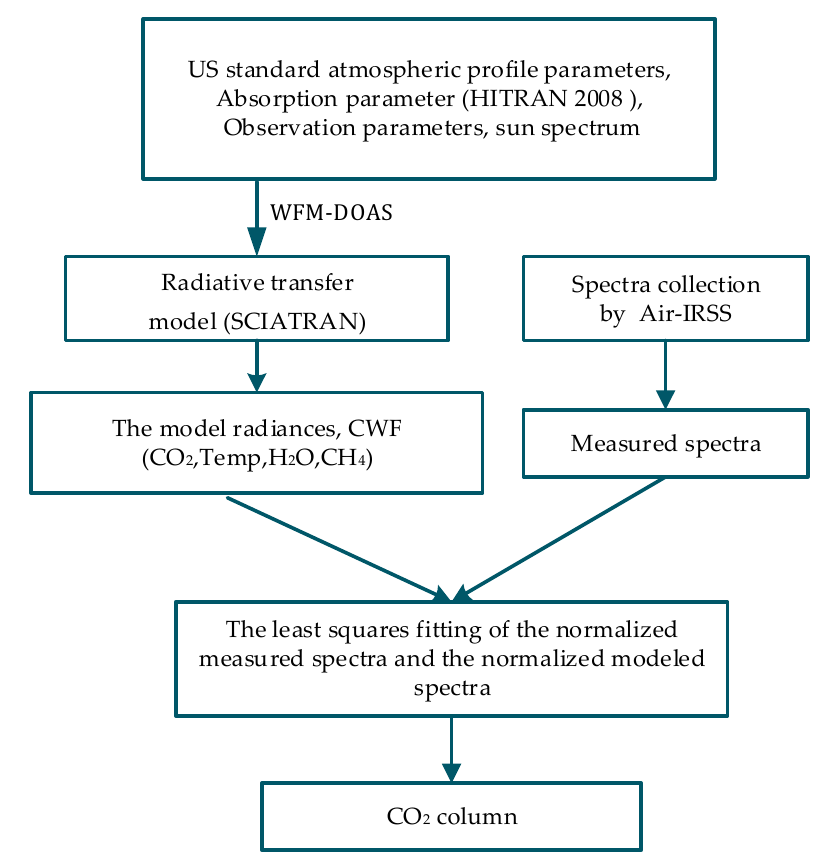
Figure 2. WFM-DOAS algorithm implementation process.